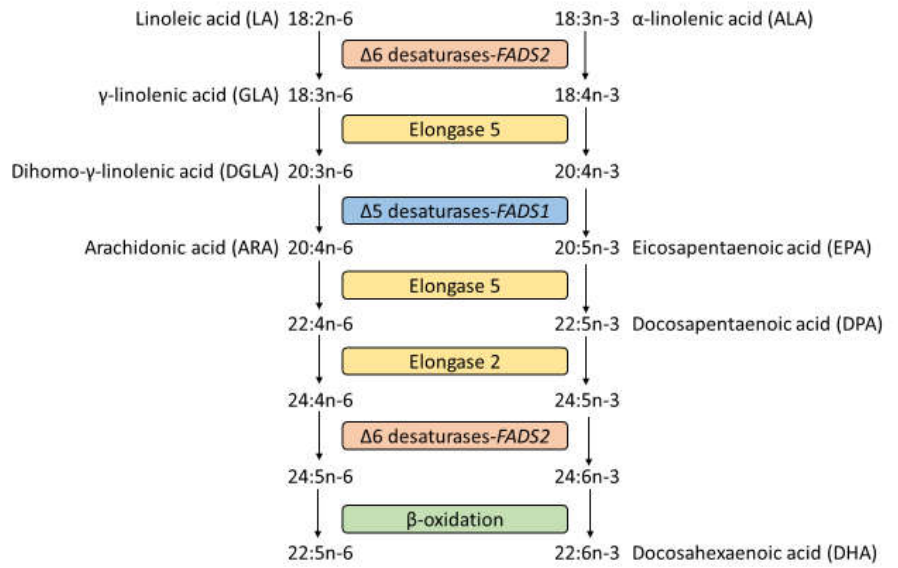
Figure 1. The n − 6 and n − 3 polyunsaturated fatty acid metabolism pathways. Figure 1. The n−6 and n−3 polyunsaturated fatty acid metabolism pathways. FADS1 resides on chromosome 11q12–q13.1, and the SNP rs174547 (T/C) located FADS1 resides on chromosome 11q12–q13.1, and the SNP rs174547 (T/C) located in intron 9 of FADS1 regulates FADS1 (or Δ-5 desaturase) expression [2,6]. Nakayama et al. reported that the copy number of the minor allele for the SNP rs174547 was significantly